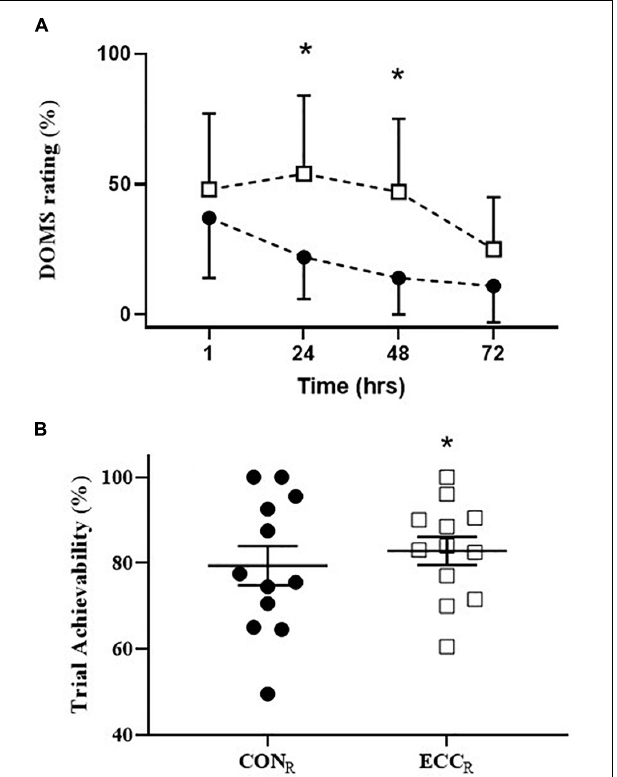
FIGURE 4 | (A) Delayed onset of muscle soreness (%) ( n = 10) following CON R ( • ) and ECC R ( (cid:3) ) trials at time points 1, 24, 48, and 72 h post exercise. * P < 0.05 ECC R versus CON R at time points 24 and 48 h post exercise. Data is expressed as mean ± SEM (B) trial achievability (%) ( n = 12) for CON R ( • ) and ECC R ( (cid:3) ) as reported by the participants following the completion of each trial. * P < 0.05 ECC R versus CON R . Data is expressed as individual data points with mean ±